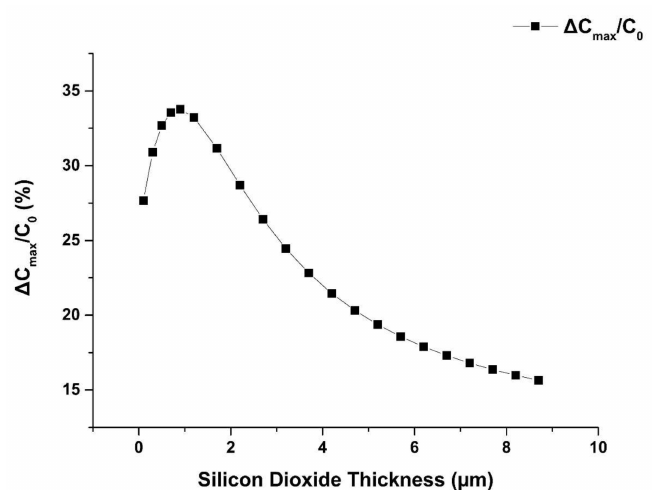
Figure 4. Influence of silicon dioxide thickness on the sensor sensitivity. For increasing silicon dioxide layer thickness, the full sensitivity increases first and then decreases past an optimal value.